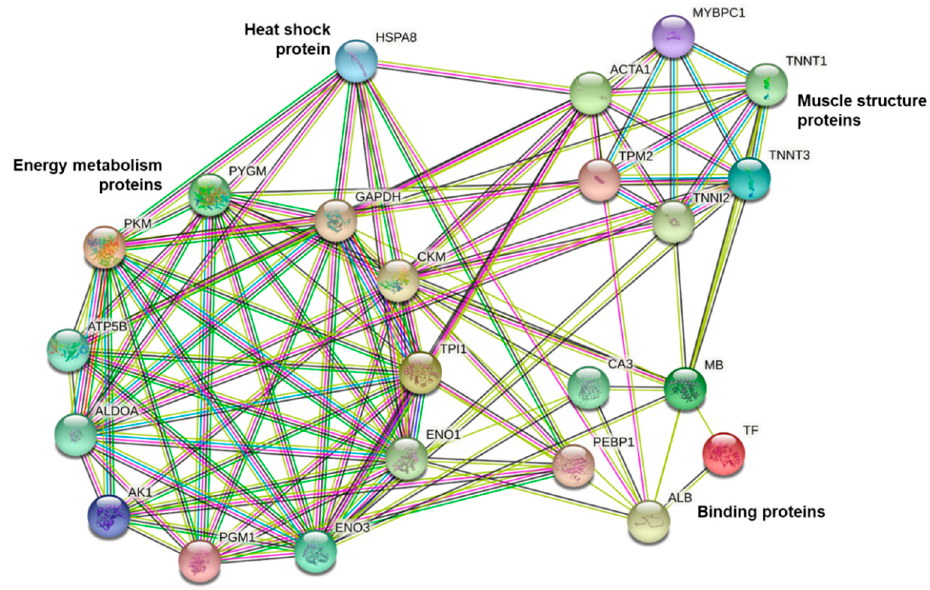
Figure 6. Analysis of protein-protein interactions using the differentially expressed proteins in muscle tissue ( Longissimus thoracis ) of feedlot-finished immunocastrated heifers and steers F1 Montana-Nellore.